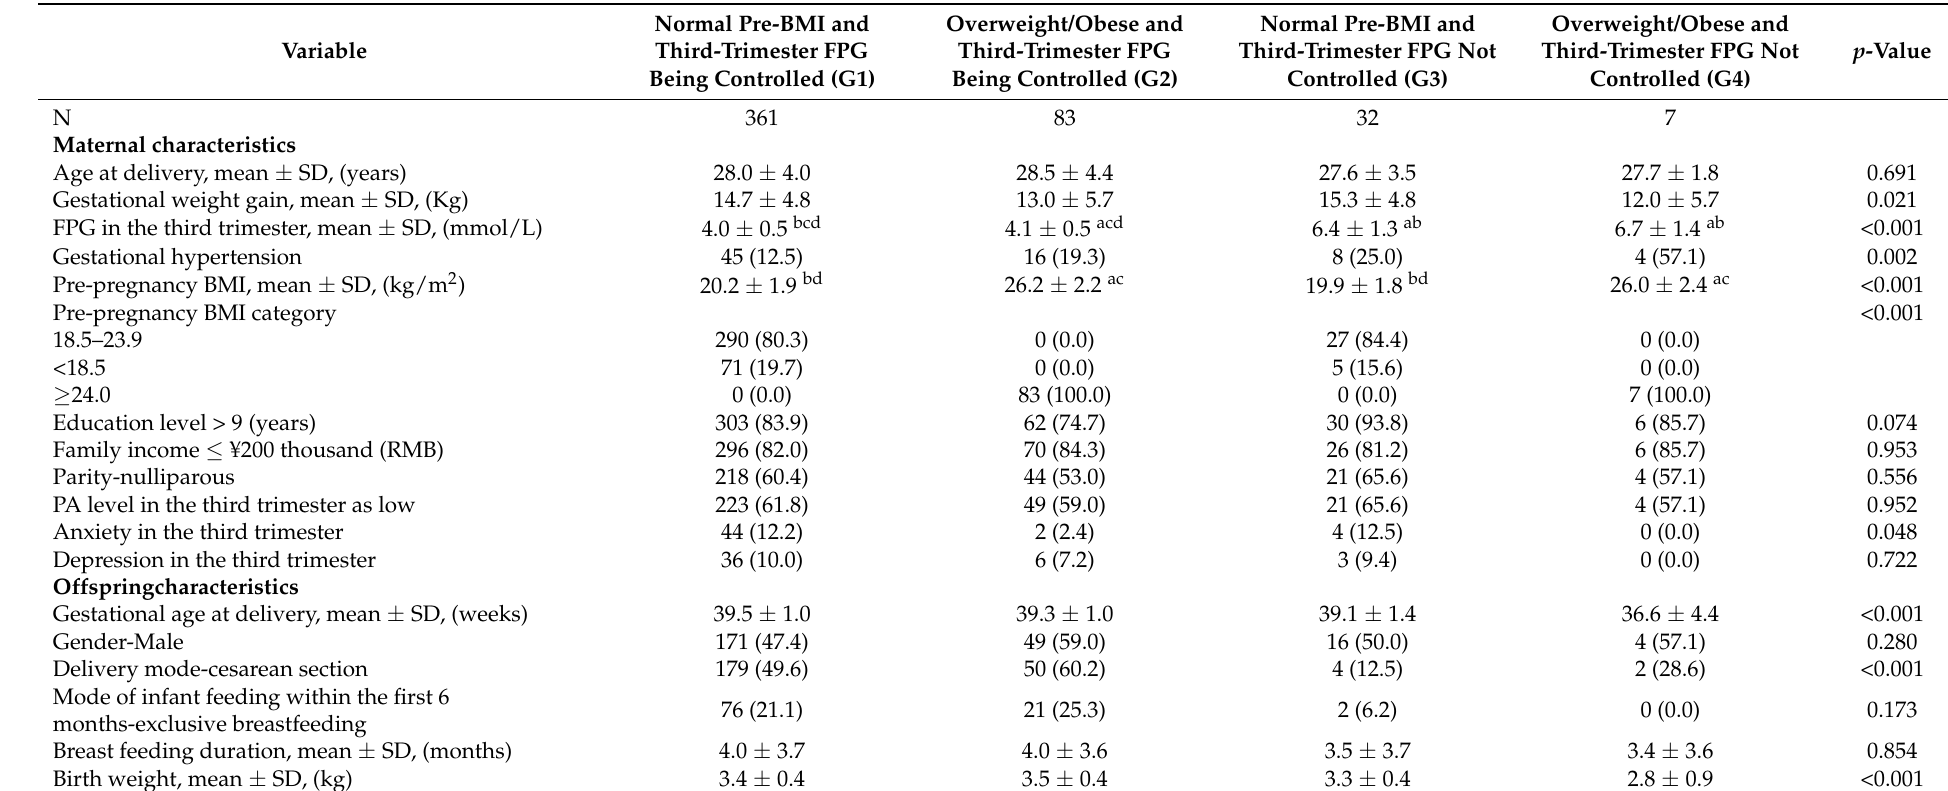
Table 1. Characteristics of pregnant-offspring pairs according to four groups by pre-pregnancy BMI and third-trimester FPG ( n = 483).